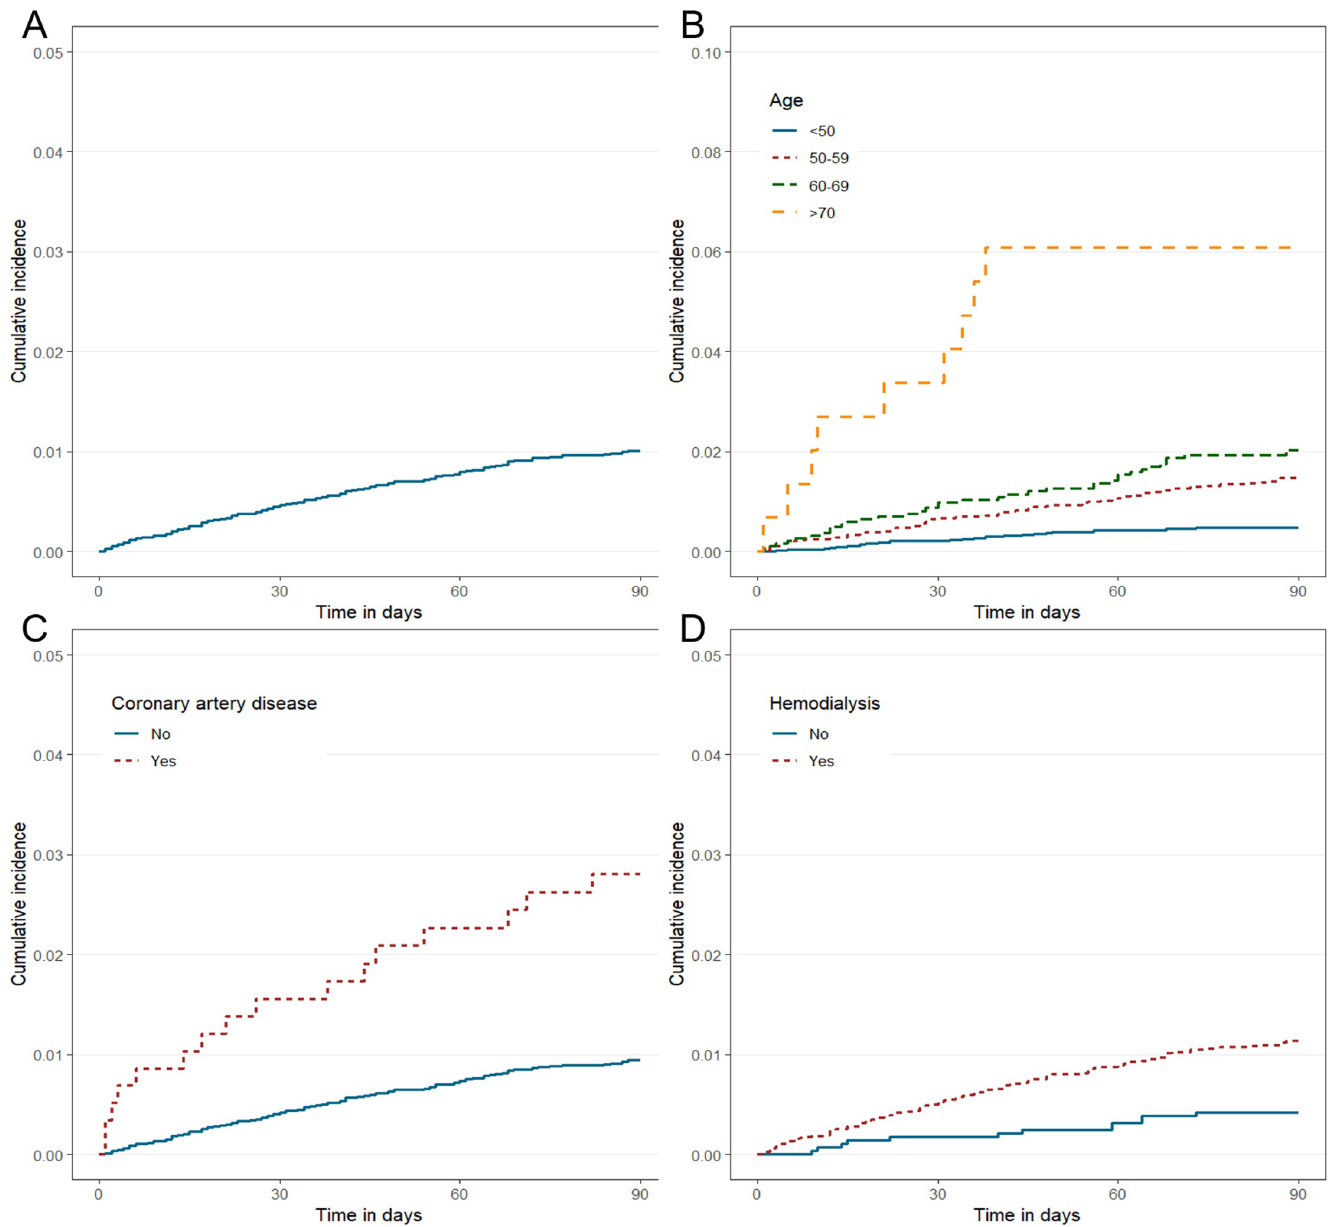
Fig 1. Cumulative incidence of mortality according to common independent factors of both 1- and 3-month mortality after kidney transplantation. (A) Total incidence. (B) Older age, (C) Coronary artery disease, and (D) Hemodialysis were associated with worse outcome.